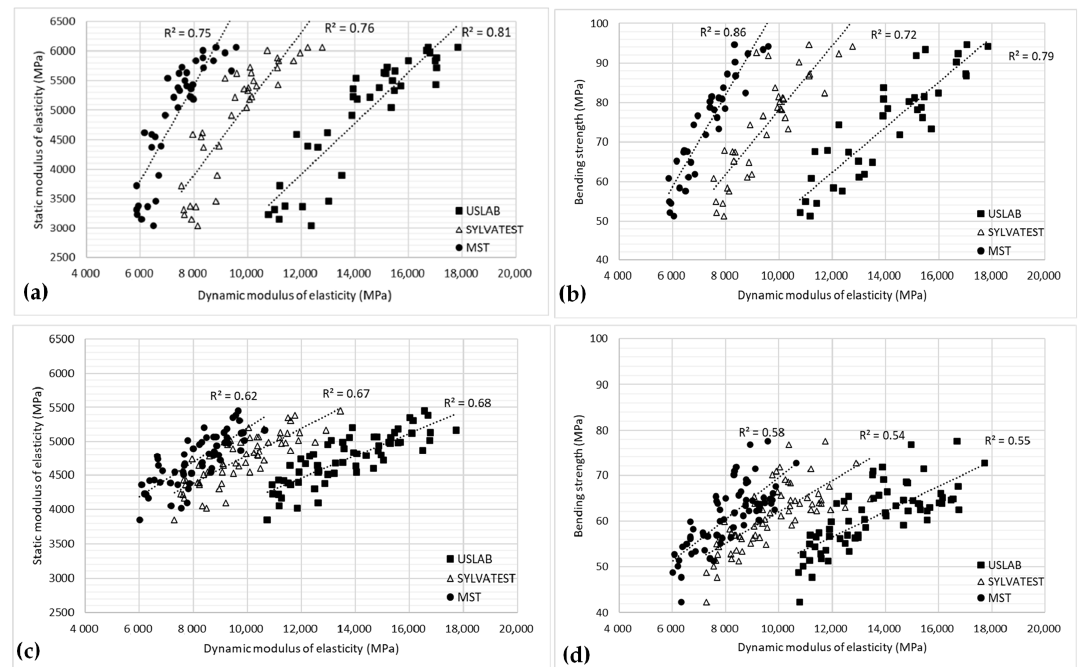
Figure 8. ( a ) Linear regressions between the dynamic modulus of elasticity and static modulus of elasticity in conditioned specimens ( b ) dynamic modulus of elasticity and bending strength in conditioned specimens ( c ) dynamic modulus of elasticity and static modulus of elasticity in saturated specimens and ( d ) dynamic modulus of elasticity and bending strength in saturated specimens, of Platanus × hybrida